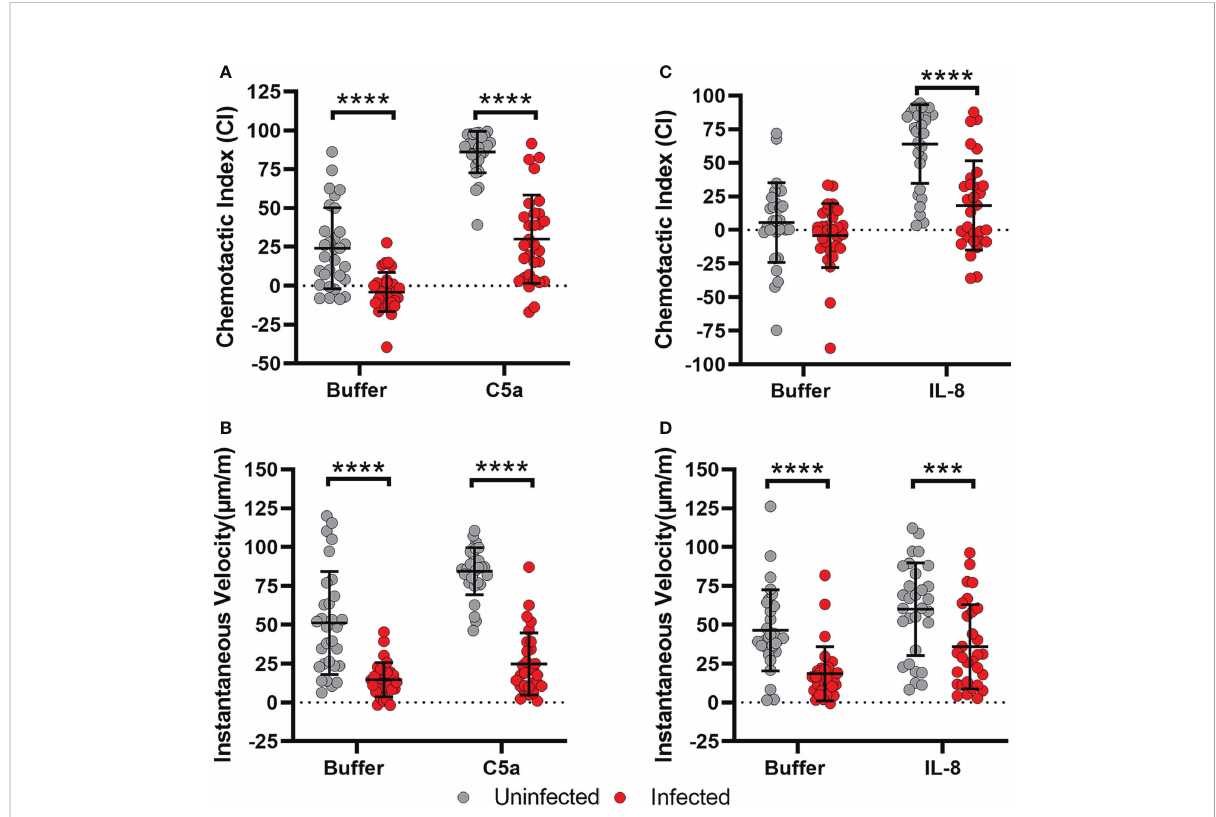
FIGURE 2 Migration of infected cells toward C5a and IL-8 is also impaired. (A, B) Chemotactic indices and instantaneous velocities of control and H . pylori -infected PMNs migrating in a C5a gradient. (C, D) Chemotactic indices and instantaneous velocities ( m m/min) of control and infected PMNs migrating in an IL-8 gradient. Graphs indicate the mean ± SD from three independent experiments. Symbols show individual cell data. Statistical signi fi cance was determined by two-way ANOVA and Tukey ’ s multiple comparisons post-test. *** p <0.001, **** p <0.0001, as